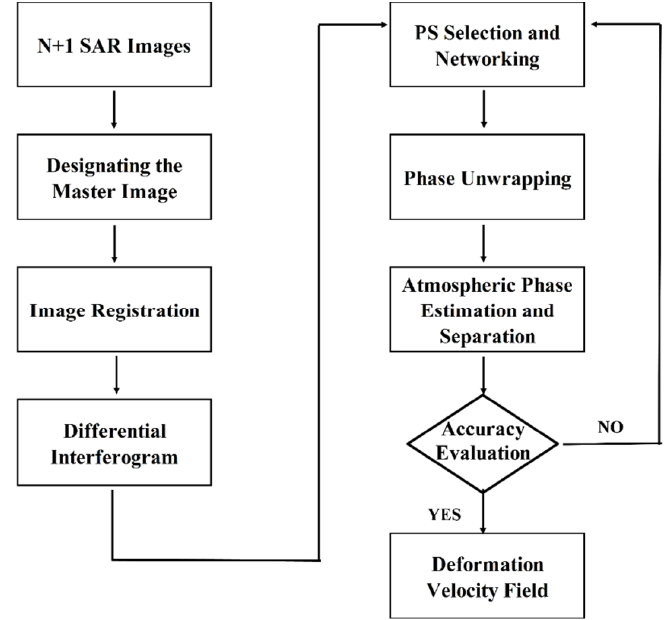
Figure 4. The diagram of data processing with PS-InSAR.